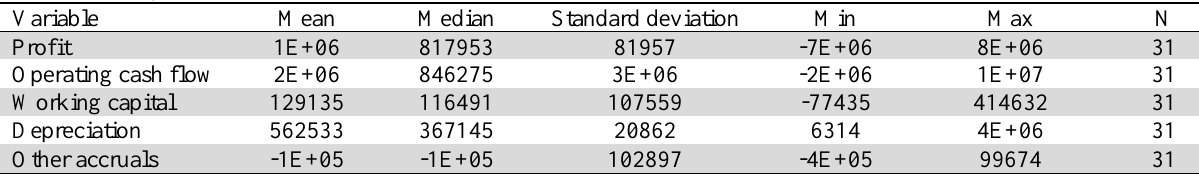
The summary of some basic statistics for the fourth quartile